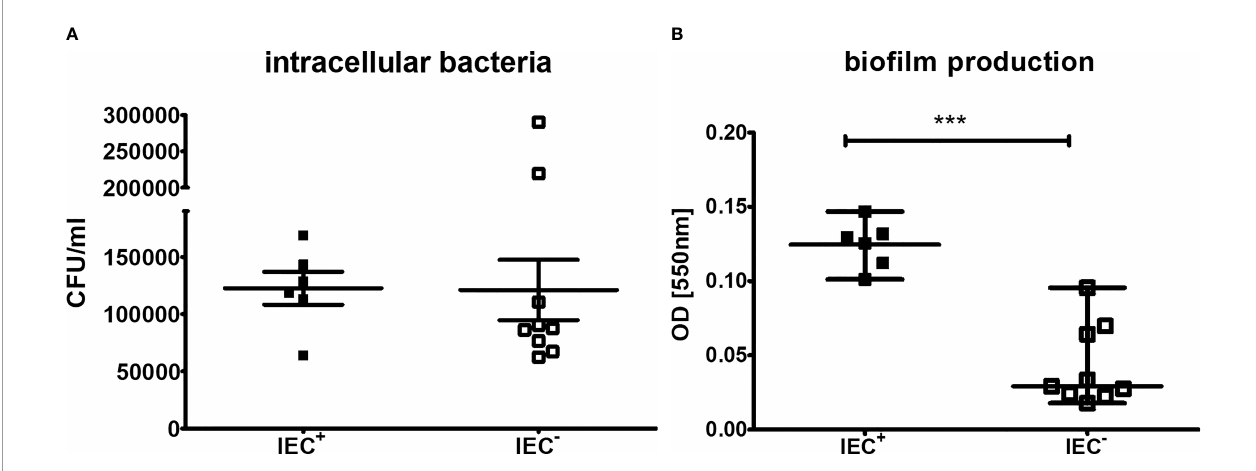
FIGURE 5 | Invasion and intracellular survival in differentiated neutrophils and bio fi lm production of clinical isolates. Capacity of S. aureus clinical isolates to (A) invade neutrophils and survive intracellular and (B) form bio fi lm. (A) For measurements of invasion and intracellular survival, differentiated HL-60 were incubated with S. aureus at a MOI of 100 2h at 37°C. Extracellular bacteria were killed using gentamicin and cells were lysed to detect intracellular bacteria following incubation for 1h to allow intracellular killing. The outliers are isolates B3 and D6. Results of three independent experiments. (B) Bio fi lm formation was measured using a crystal violet stain, experiments performed as triplicates. The comparison of two data groups were analyzed by Mann – Whitney U test (one-tailed, con fi dence intervals 95%) with ***P <